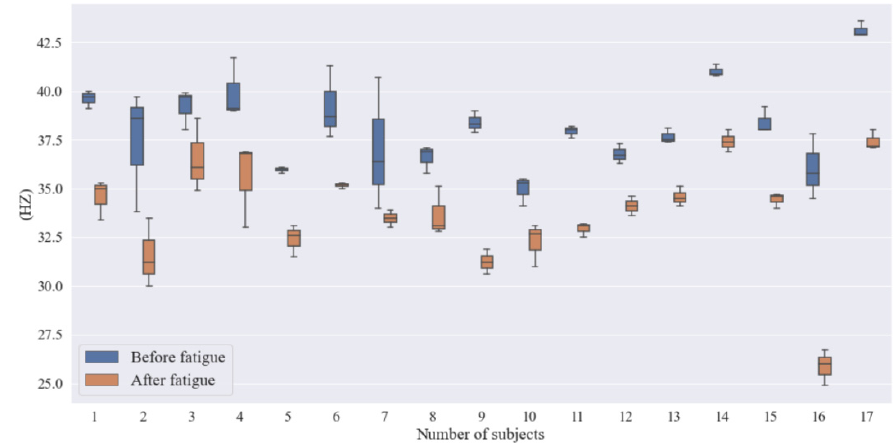
Figure 9. Flicker fusion frequency values before and after brain fatigue. Table 8. Paired samples t -test result. Std. Std. Mean Deviation